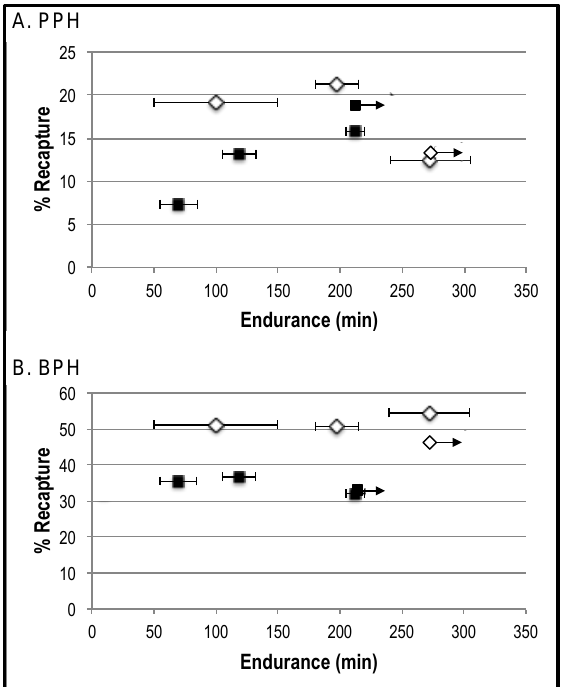
Figure 7. Summer 2008 lake recapture and average endurance swimming of endurance-screened 2N ( ◇ ) and 3N ( ■ ) quartiles of Blackwater rainbow trout ( Oncorhynchus mykiss ) in PPH (a warm, high predation lake) ( A ) and BPH (a cool, low predation lake) ( B ). Arrows represent the 4th endurance quartile, mean endurance swimming of which is unknown, but greater than that of the 3rd quartile of the same ploidy. Table 3. Mean endurance swimming of stocked and recaptured populations of 2N and 3N Blackwater rainbow trout ( Oncorhynchus mykiss ) in BPH and PPH during the summer of 2008. Units are in minutes.